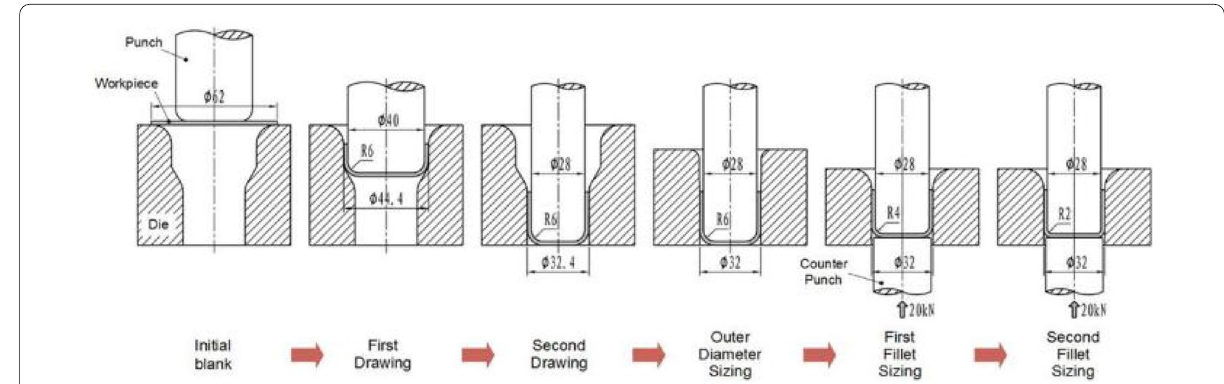
Figure 6 Schematic design of tooling for sheet forming